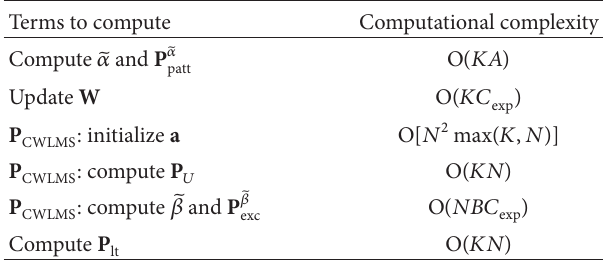
Table 1: The computational complexity of proposed array synthesis